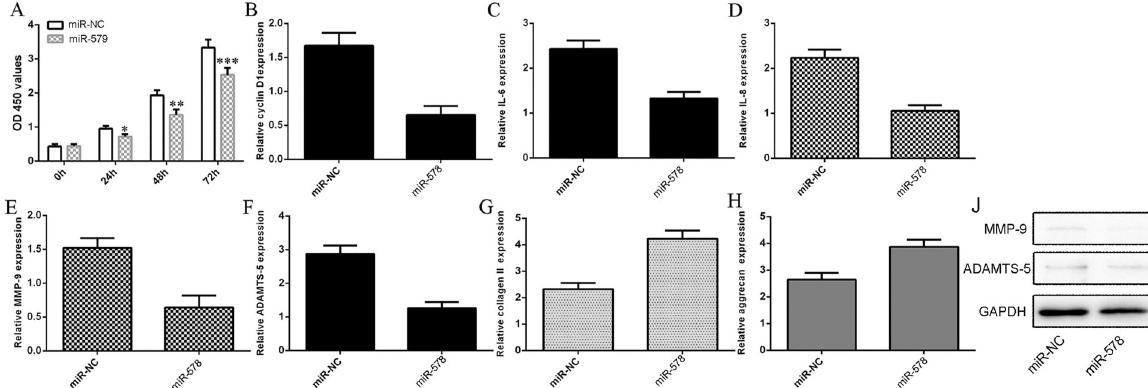
Fig. 6 Ectopic expression of miR-578 inhibited proliferation, pro-in fl ammatory cytokine secretion, and ECM degradation in NP cells. A miR-578 overexpression inhibited NP cell proliferation as shown by the CCK-8 assay. B The expression of cyclin D1 was analyzed by using qRT-PCR and GAPDH was used as the internal control. C – F Overexpression of miR-578 suppressed C IL-6, D IL-8, E MMP-9, and F ADAMTS-5 expression as shown by qRT-PCR. G, H The expression of type II collagen and aggrecan was determined by qRT-PCR assay. Ectopic expression of circ_0134111 decreased G type II collagen and H aggrecan expression in NP cells. J The protein expression of MMP-9 and ADAMTS-5 was measured by western blots. * p < 0.05, ** p < 0.01, and *** p <